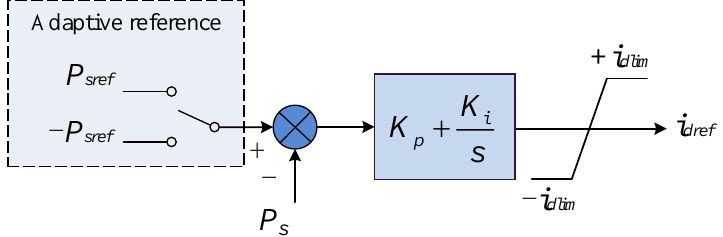
Figure 8. The adaptive reference control.